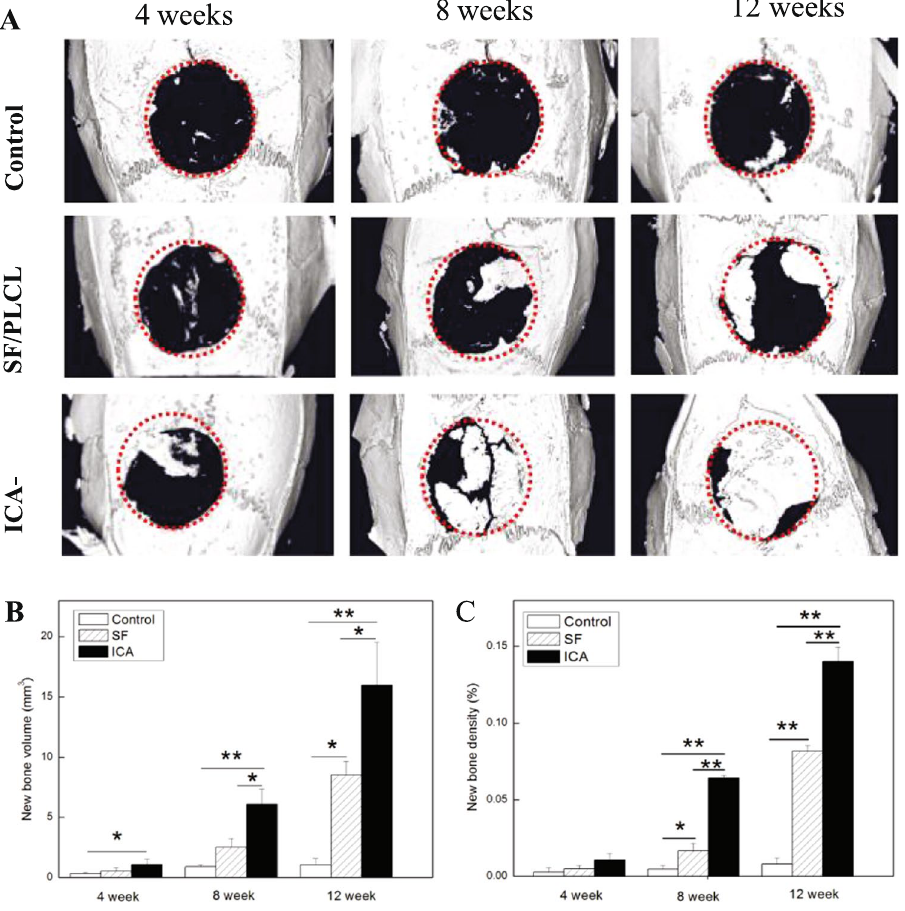
Figure 7. ( A ) μ -CT images of calvarial defects. ( B ) Quantification of percentage of new bone volume and ( C ) density in calvarial defects. * Significantly higher bone formation compared with control (note: * p < 0.05, ** p < 0.01. SF indicates SF/PLCL membrane group; ICA indicates ICA–SF/PLCL nanofibrous membrane group; The red dotted line depicts the regions of interest selected for